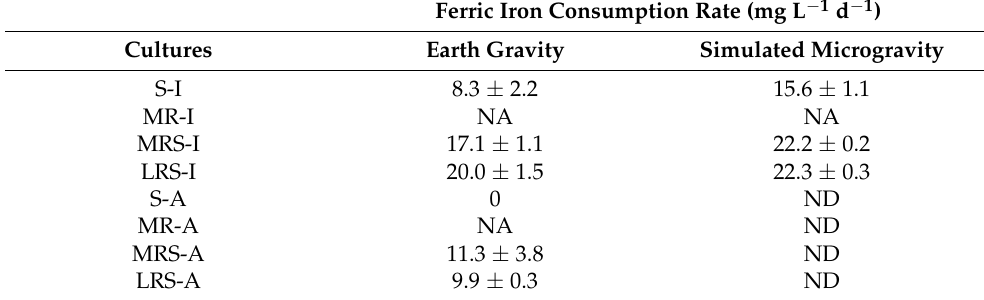
Figure 3. Cell counts of A. ferrooxidans- ionoculated (I) cultures after incubation for 20 days under Earth gravity (E) and simulated microgravity (M) conditions in the presence of 12.5 mM Fe 3+ (S); 1% Mars regolith simulants (MR), 1% Mars regolith simulants plus 12.5 mM Fe 3+ (MRS) and 1% lunar regolith simulants plus 12.5 mM Fe 3+ (LRS). H 2 /CO 2 gas mixture was added to all cultures as electron donor and carbon sources, respectively. The initial cell density was 1 × 10 7 cells mL − 1 . Error bars show standard deviations. Table 4. Average ferric consumption rates of A. ferrooxidans cultures incubated under Earth gravity and simulated microgravity conditions. S = 12.5 mM Fe 3+ only, MR = 1% Mars regolith simulant, MRS = 1% Mars regolith simulant plus 12.5 mM Fe 3+ , LR = 1% lunar regolith simulant plus 12.5 mM Fe 3+